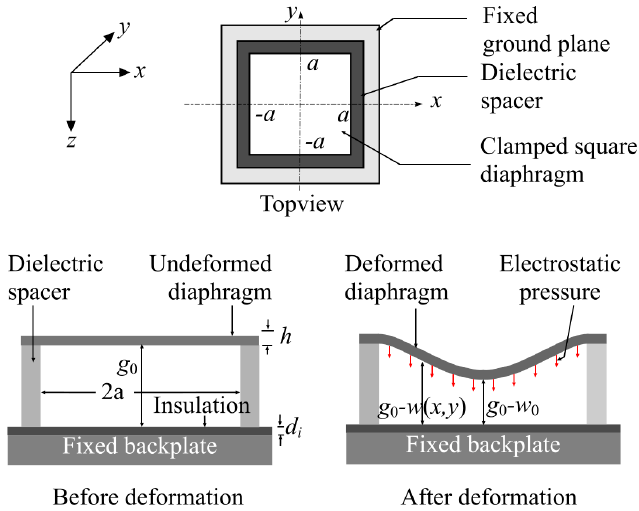
Figure 2. Operation of the MEMS deformable diaphragm variable